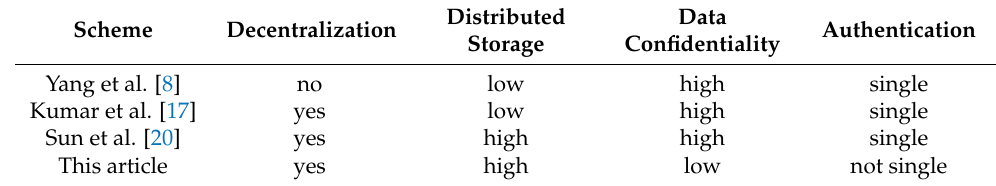
Table 3. Authentication scheme comparison.